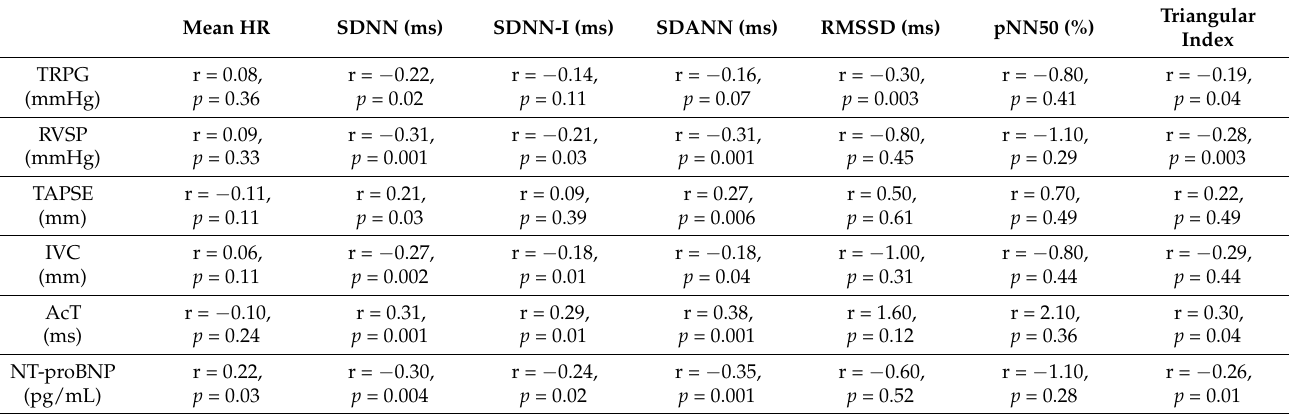
Figure 1. Correlations in all low and intermediate risk patients with acute pulmonary embolism (n = 162) between standard deviation of intervals of all normal beats in 24 h Holter monitoring and tricuspid regurgitation peak gradient (r = 0.22, p = 0.016)—left side of the figure—and N-terminal pro-B type natriuretic peptide concentration (r = − 0.30, p = 0.004)—right side of the figure. Table 2. Correlations between time-domain heart rate variability indices, right ventricle overload echocardiographic parameters and also N-terminal pro B type natriuretic peptide concentration in all low and intermediate risk patients with acute pulmonary embolism ( n = 162) a